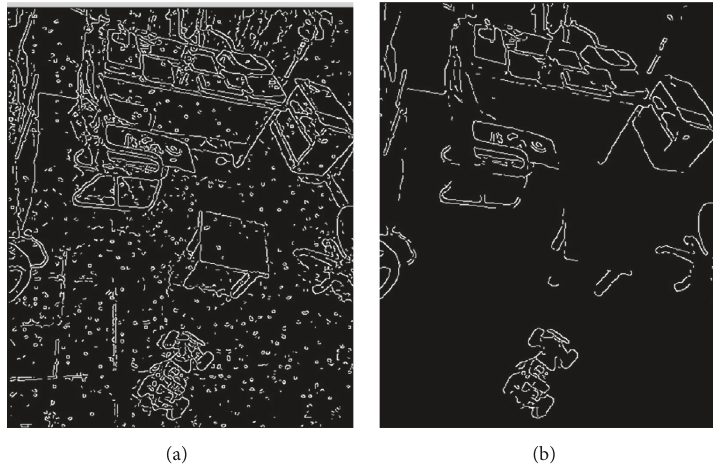
Figure 24: Comparison results for noised tested